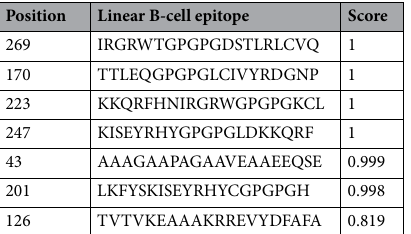
Table 4. A list of linear B-cell epitopes predicted by the